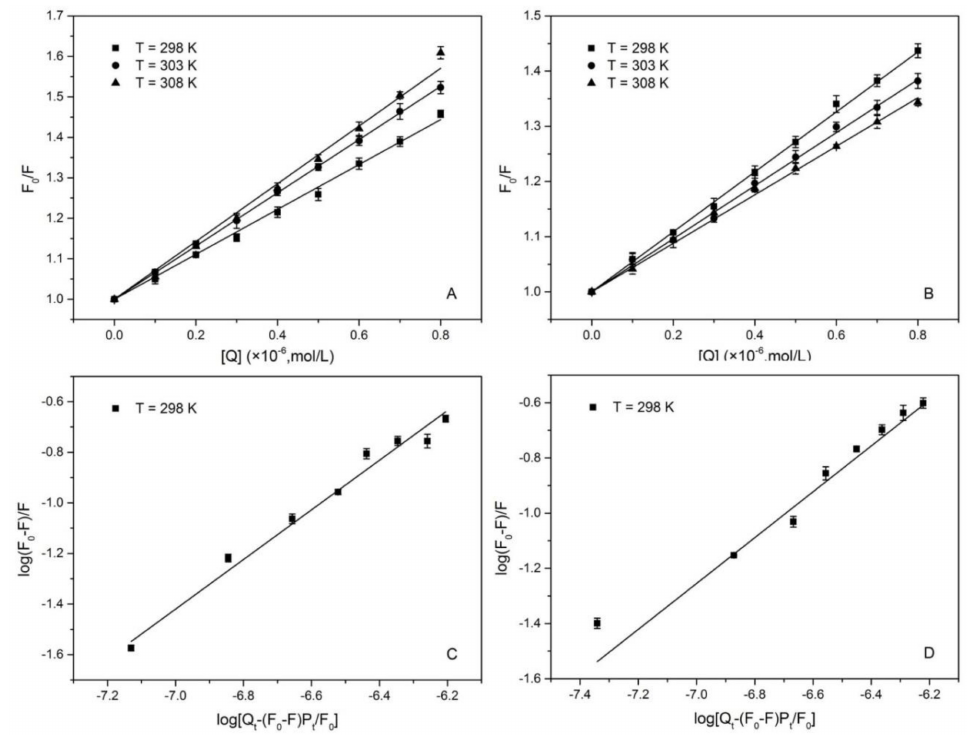
Figure 2. The plots of Stern-Volmer. ( A ): HSA-3-bromocarbazol; ( B ): HSA-1,3,6,8- tetrabromocarbazole) at 298, 303, 308 K and log [( F HSA-3-bromocarbazole and HSA-1,3,6,8-tetrabromocarbazole systems; ( C ): HSA-3-bromocarbazol; ( D ): HSA-1,3,6,8-tetrabromocarbazole) at 298 K. Data are mean ± SE (bars) ( n =